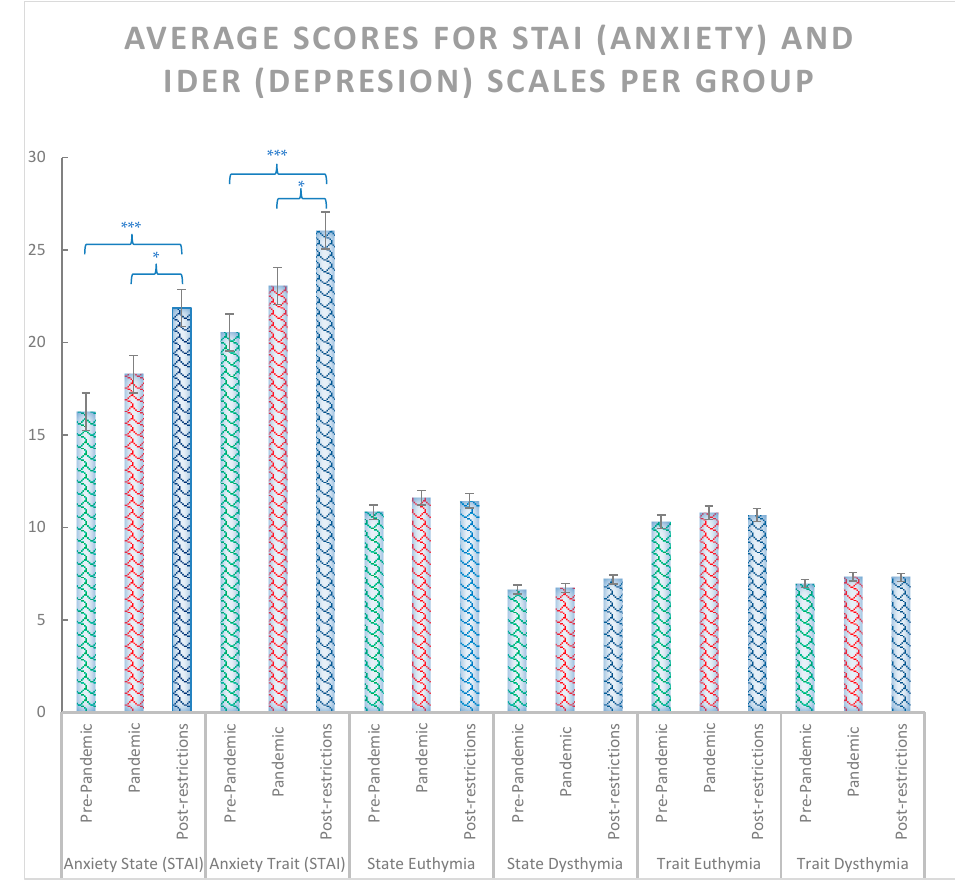
Figure 2. Average scores for STAI (anxiety) and IDER scales (depression) for pre-pandemic, pan- demic, and post-pandemic group. Where *** = p < 0.001, and * = p < 0.05. Bars indicate error rates.